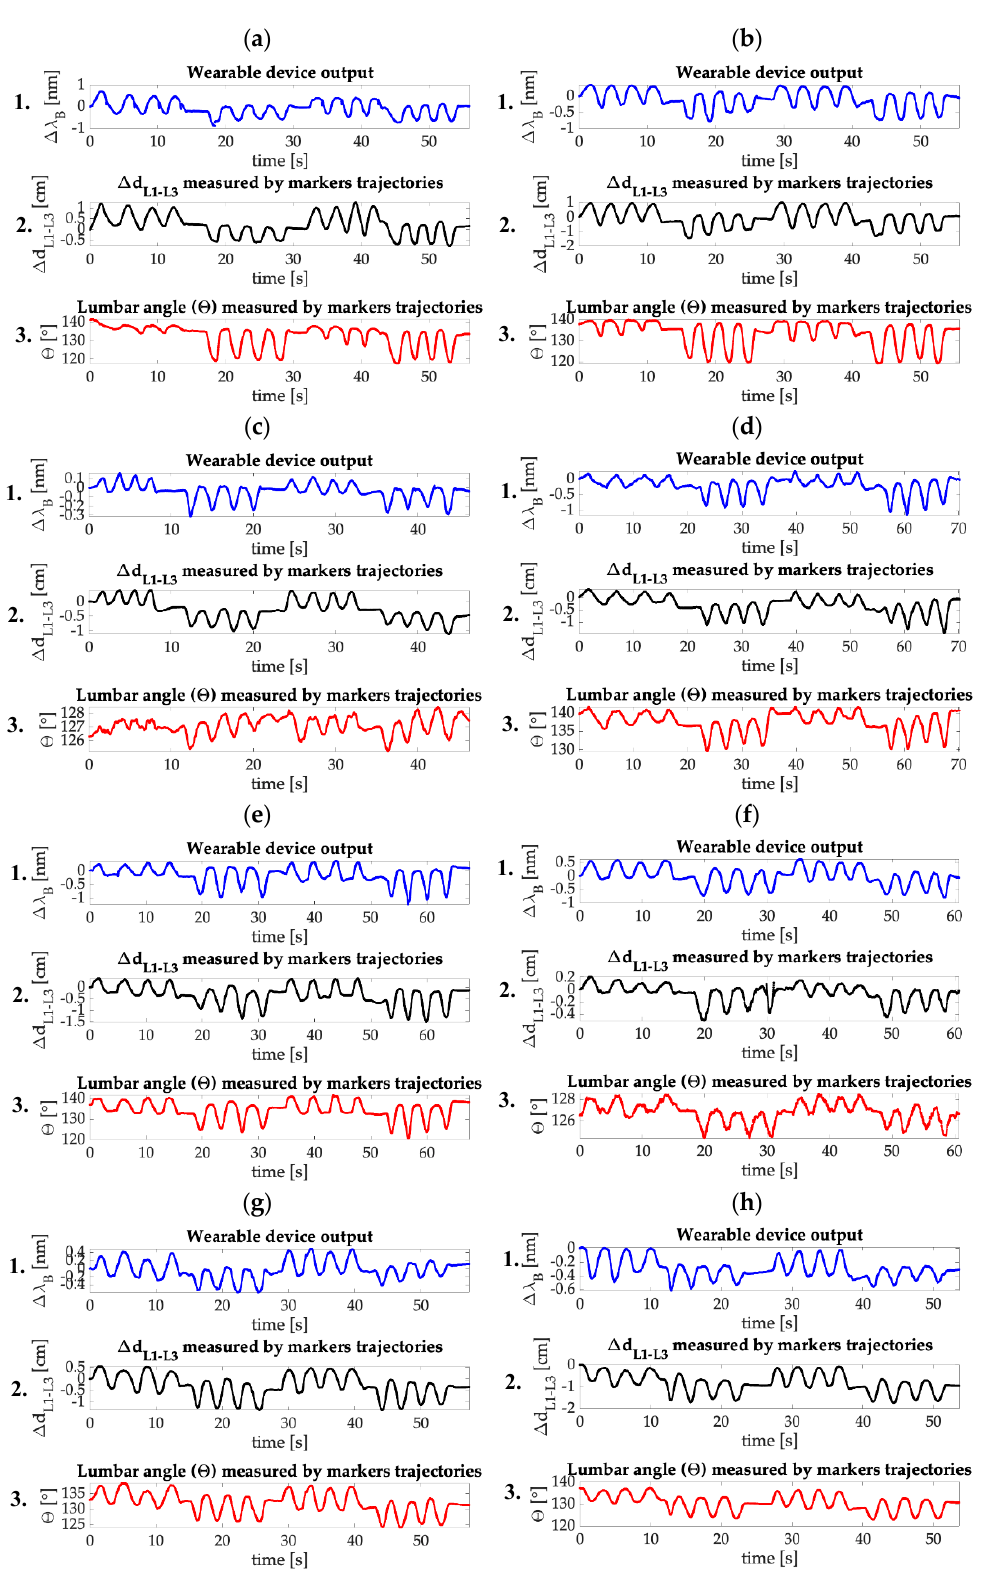
Figure 7. ( 1 ) The wearable output ( ∆ λ B ), ( 2 ) the distance between L1 and L3 ( ∆ d L3 − L1 ) and ( 3 ) the lumbar angle ( θ ) trends obtained per each trial. ( a ): Trial 1; ( b ): Trial 2; ( c ): Trial 3; ( d ): Trial 4; ( e ): Trial 5; ( f ): Trial 6; ( g ): Trial 7; ( h ): Trial 8.